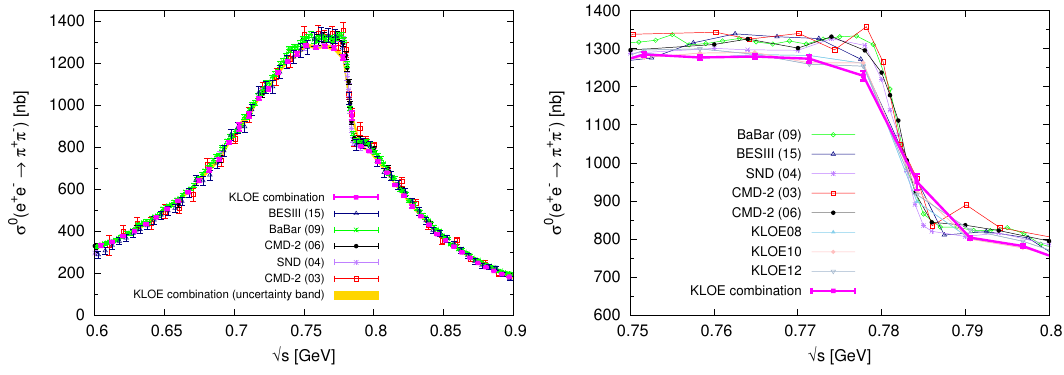
(b) Cross section in the (cid:26) (cid:0) ! interference region